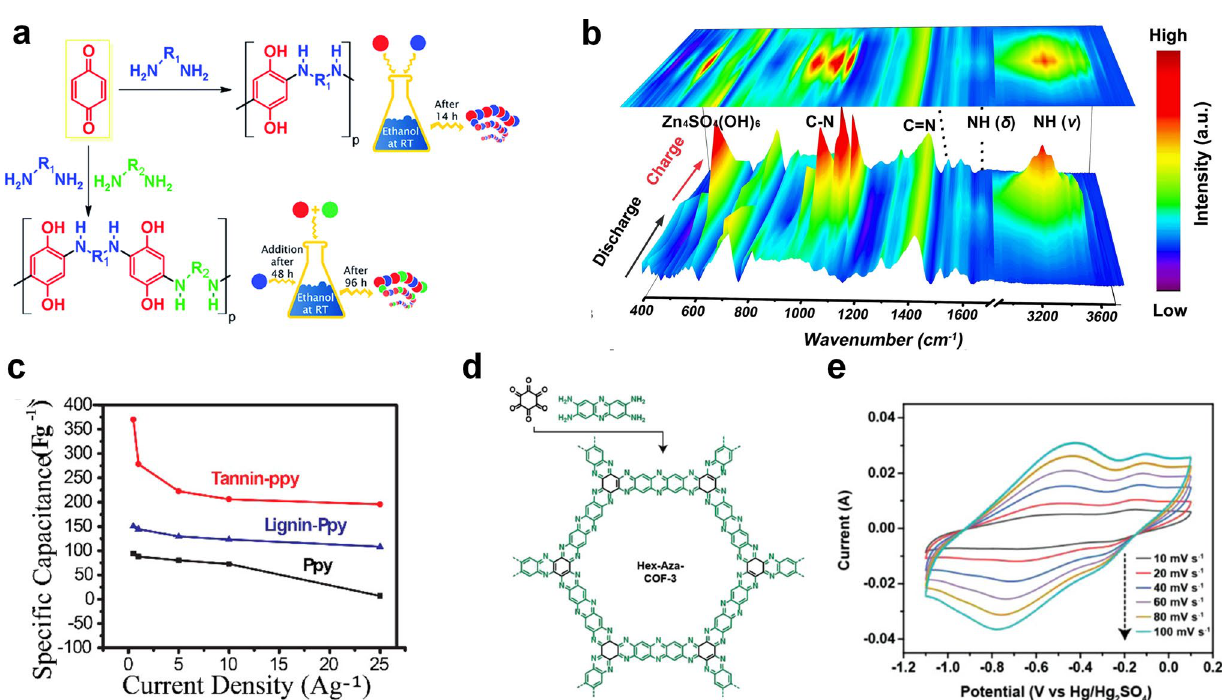
Fig. 8 a Schematic of preparation of bipolymer and terpolymer [94]. Copyright 2017, The Royal Society of Chemsitry. b Ex situ FTIR spectra of PO electrodes during charging and discharging process [96]. Copyright 2021, Wiley–VCH. c Specific capacitance of Tn/Ppy, Lig/Ppy, and Ppy at different current densities [97]. Copyright 2017, American Chemical Society. d The synthetic route of Hex-Aza-COF-3. e CV curves of Hex-Aza-COF-3 at various scan rates [100]. Copyright 2020,